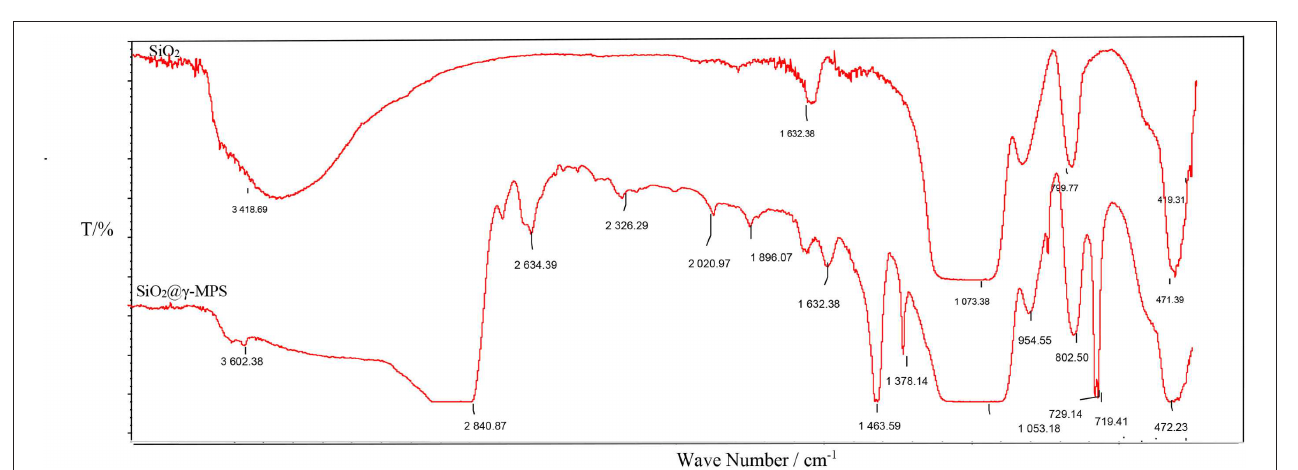
FIGURE 3 | Comparison of infrared spectra before and after nano-silica